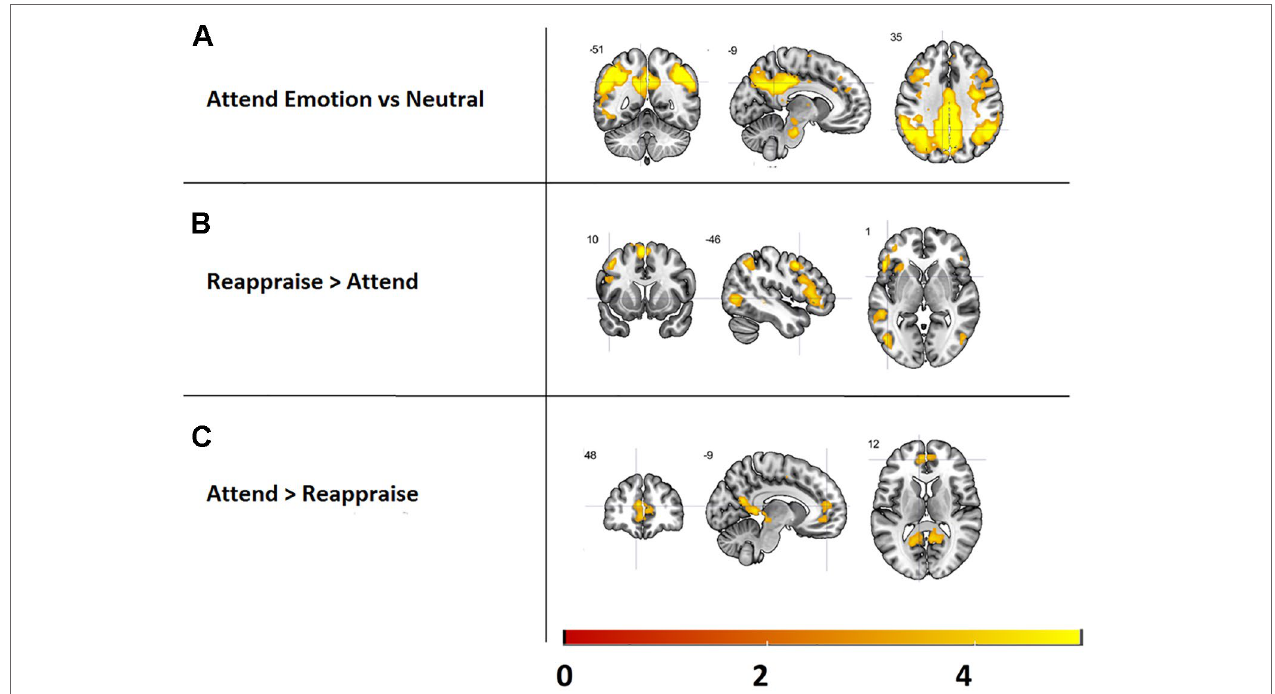
FIGURE 3 | Main effects of the emotion reappraisal task, presented at a threshold of k > 5, p < 0.001. Top: Brain areas activated while attending emotional images versus neutral images. Middle: activated brain areas during reappraising vs. attending images. Bottom: regions more activated during attending images vs. reappraising